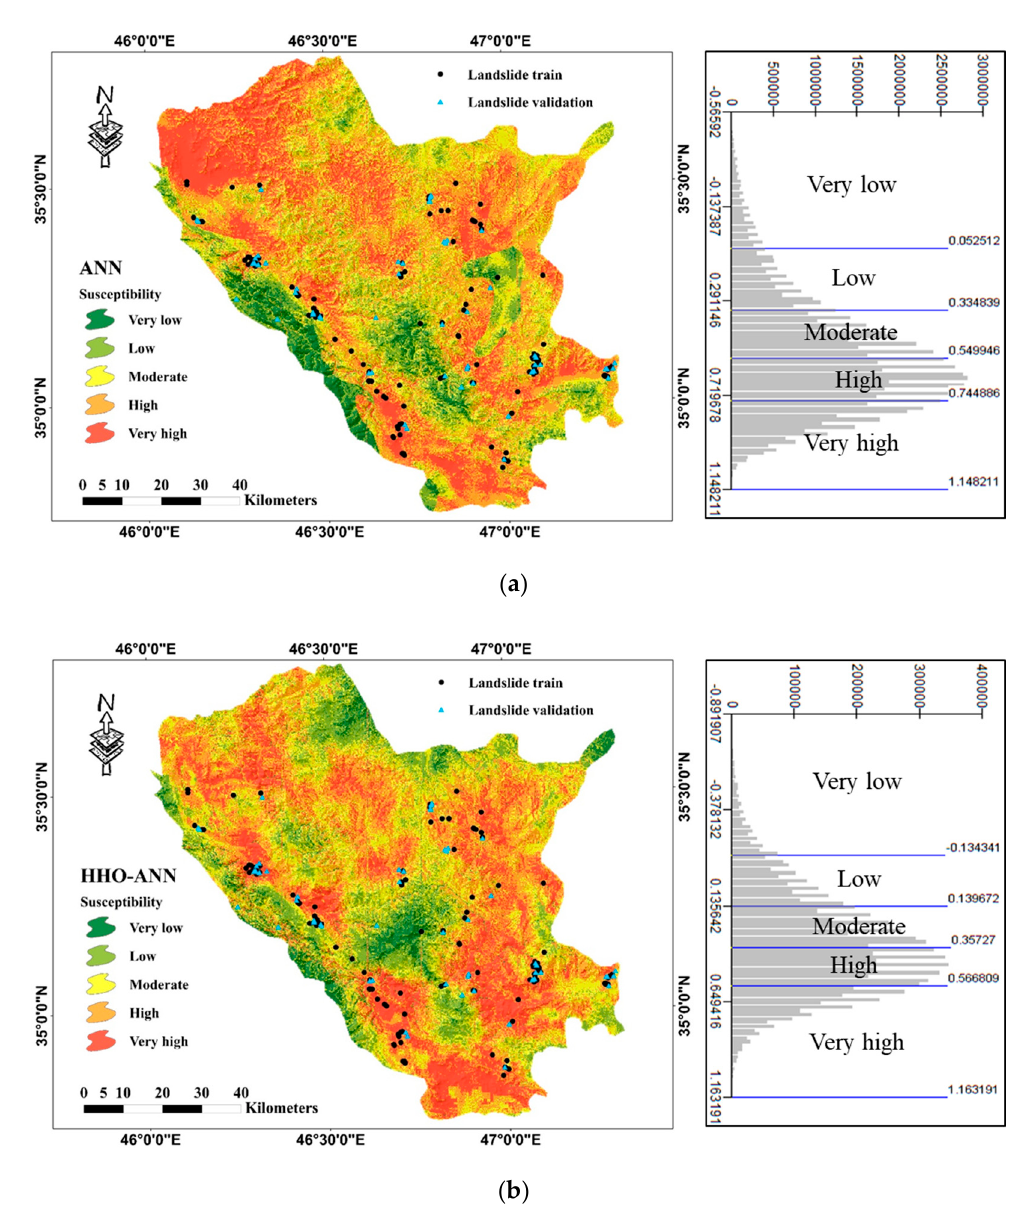
Figure 7. Landslide susceptibility maps developed by ( a ) ANN and ( b ) HHO–ANN models.